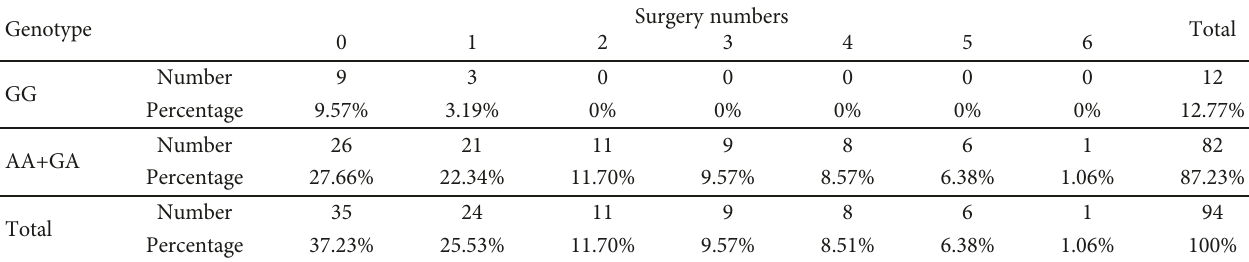
Table 2: Surgery numbers in risky allele carrier and nonrisky allele carrier among the cohort of Crohn ’ s disease patients.